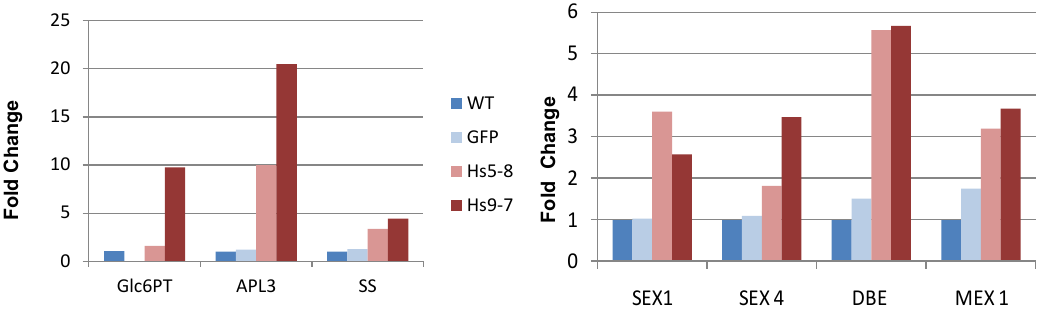
Figure 10. There was a 20% increase in anthocyanin in the Hs PIPKIα lines. Three week-old seedlings were harvested and anthocyanin was extracted and quantified as described in the Experimental Section. The data are the means ± SD of 3 biological